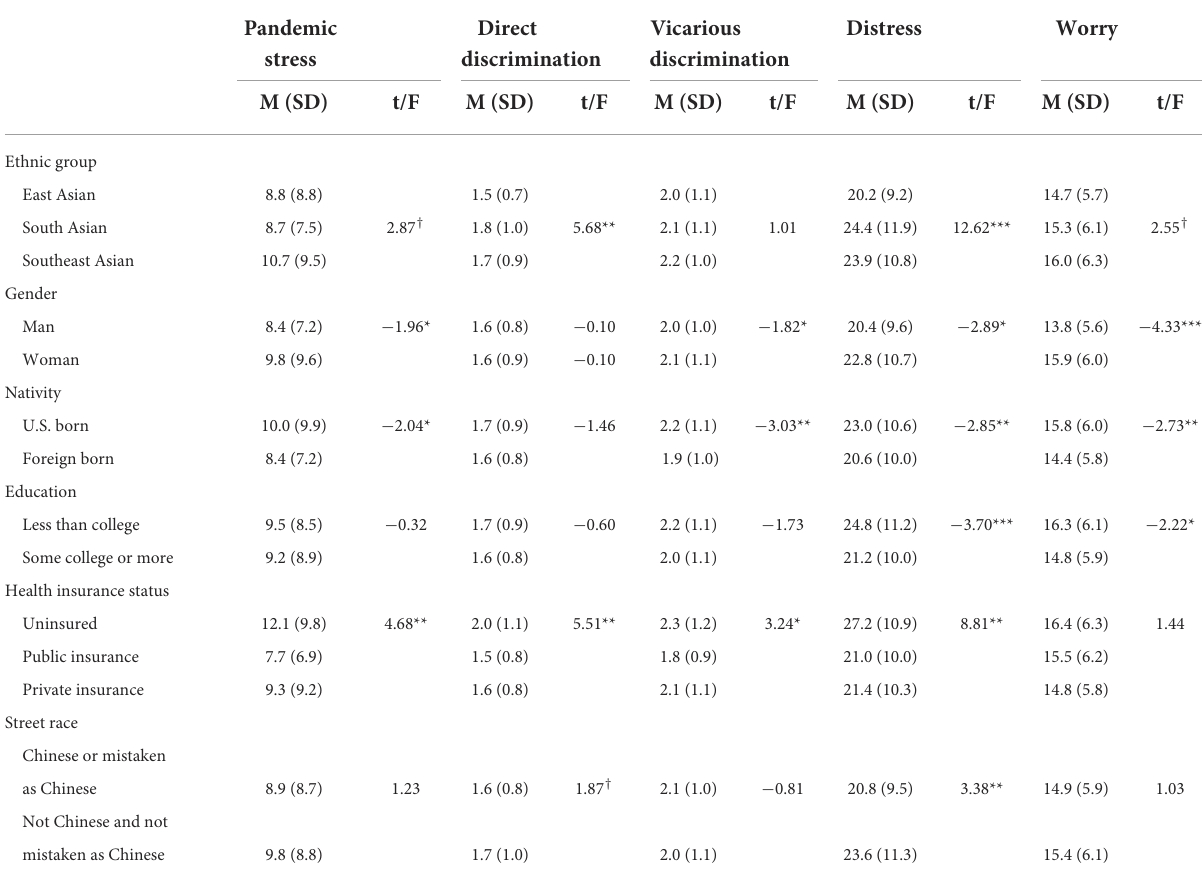
TABLE 2 Comparisons of study variables by demographic characteristics.